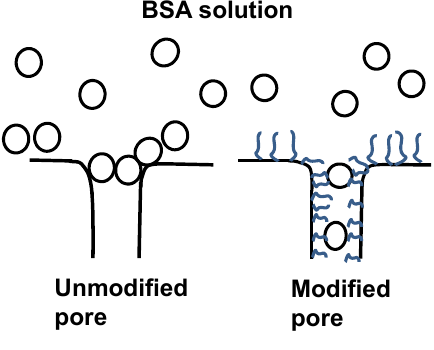
Figure 1. Schematic representation of the effect of modification of polyethersulfone (PES) membrane pores on rejection of proteins. BSA